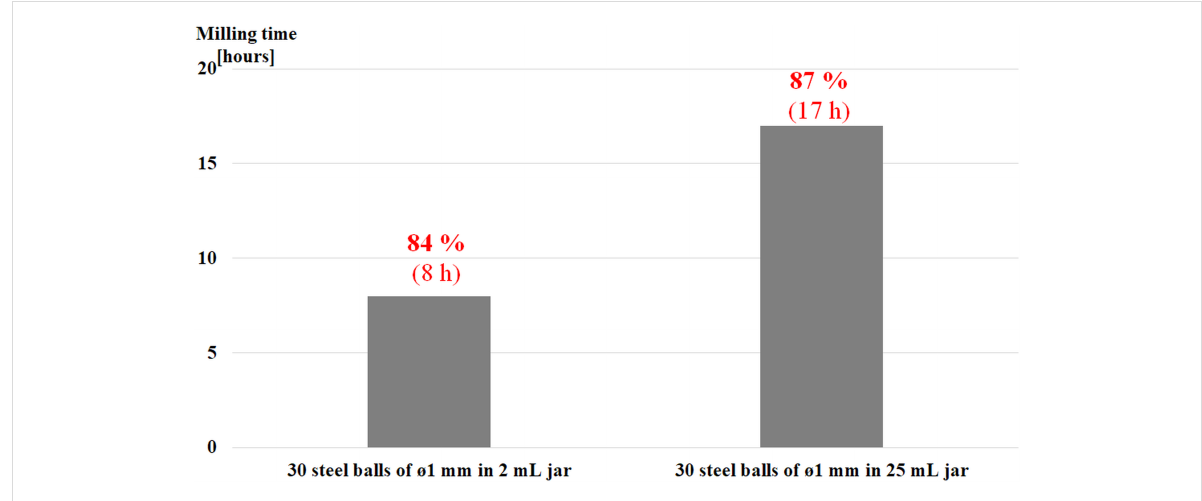
Figure 1: Effect of jar size on the reaction time using an equal number (30) of steel balls (ø 1 mm) for the Ts → N 3 exchange reaction in glass vials at 550 min − 1 sun wheel speed.